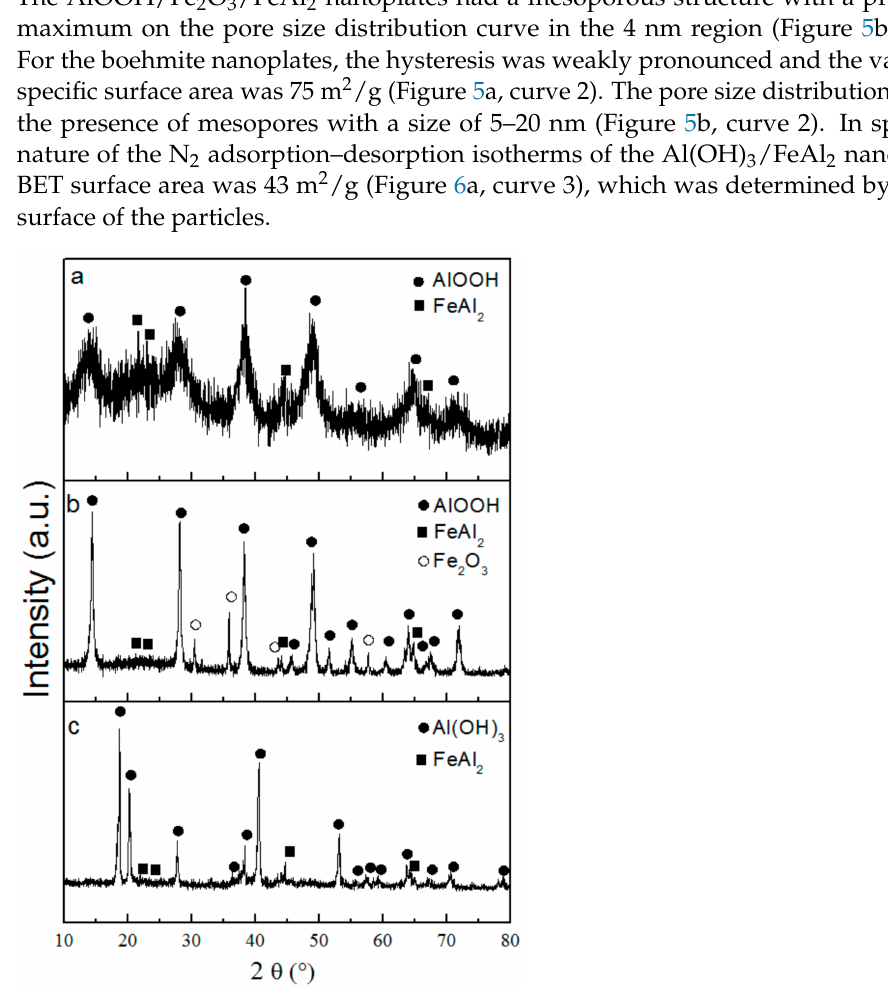
Figure 4. XRD patterns of nanosheets ( a ), nanoplates ( b ) and nanorods ( c ).